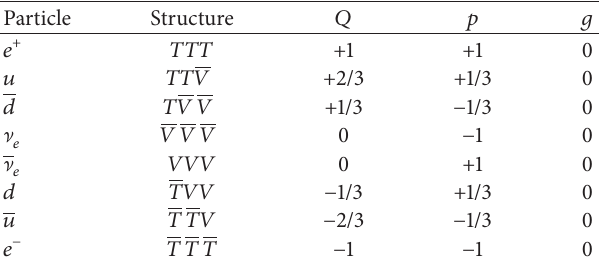
Table 5: CGM of first generation of leptons and